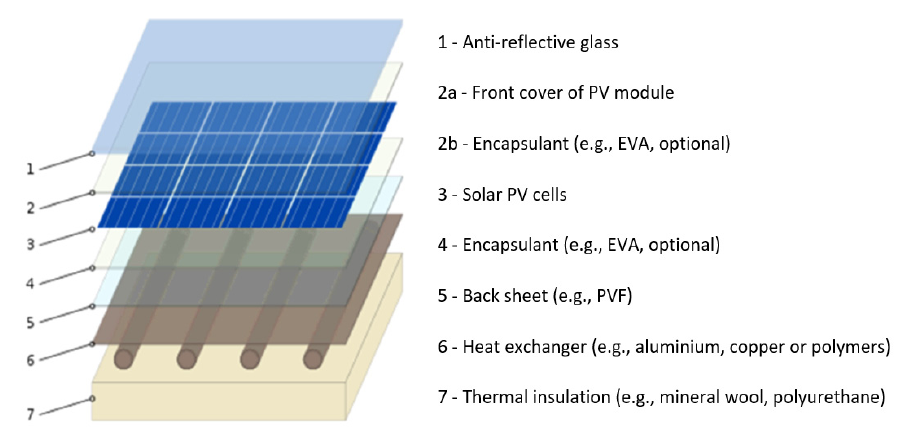
Figure 1. Schematic cross-section of a covered flat-plate photovoltaic thermal (PVT) collector